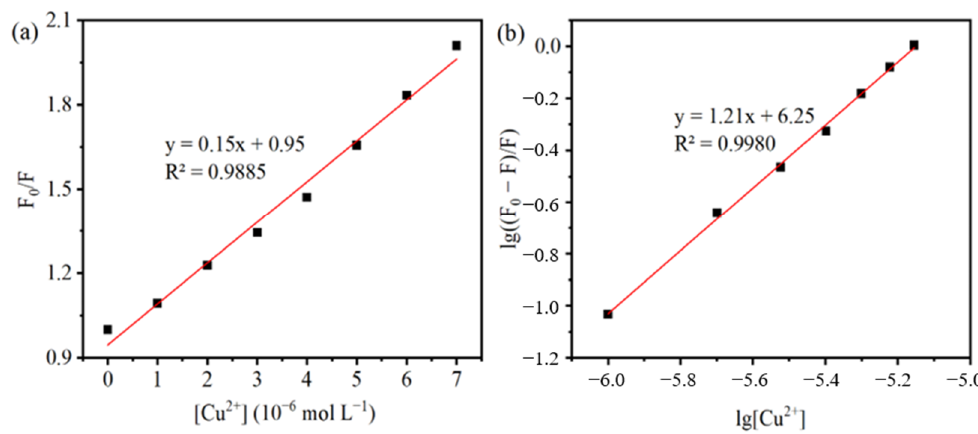
Figure 8. ( a ) The Stern–Volmer and ( b ) lg((F 0 − F)/F)~lg[Cu 2+ ] plots of CMC−GE−AQ with Cu 2+ . (CMC−GE−AQ: 1.5 × 10 −4 g mL −1 ; solvents: DMF/H 2 O solution ( v / v = 8/2, pH = 7); excitation wavelength: 425 nm; excitation slit: 5 nm.)